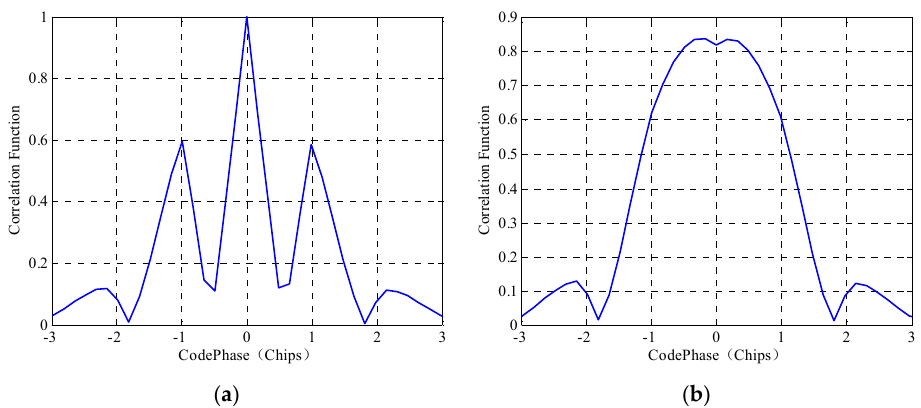
Figure 10. Equivalent effect diagram of sidelobes suppression. ( a ) Correlation function after anti- jamming, ( b ) Delay component of correlation function.